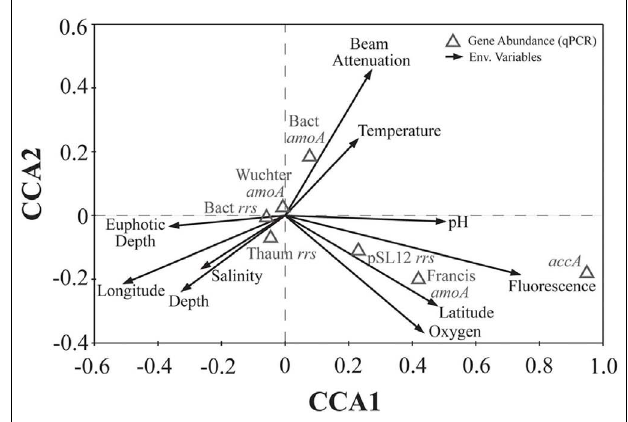
FIGURE 8 | Canonical correspondence analysis (CCA) ordination plot of qPCR-estimated abundances for rrs , amoA , and accA genes and environmental data. The length and angle of arrows shows the contribution of a particular environmental variable to the CCA axes. Fluorescence, relative fluorescence, chlorophyll a equivalents; beam attenuation, turbidity. Eigenvalues, correlation values, and percentage variance for CCA are given in TableA6 in